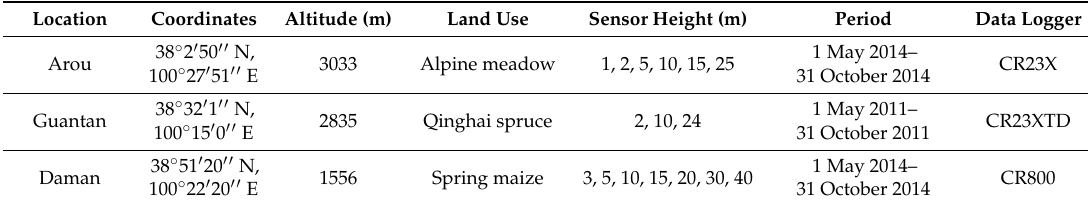
Table 1. Description of the three used